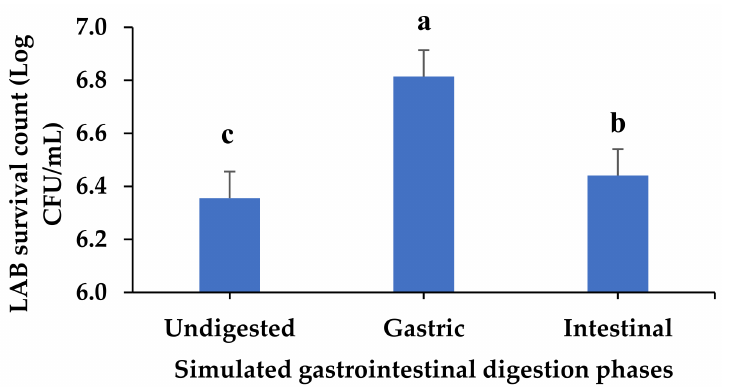
Figure 5. Surviving LAB count in simulated gastrointestinal digesta from fermented VOP 1 cowpea leaf smoothie. The data presented on the graphs consist of average quantities ± SD of three indepen- dent samples. The different letters on the bars represent statistically significant differences ( p < 0.05); Log CFU/mL = logarithmic colony-forming unit per millilitre of